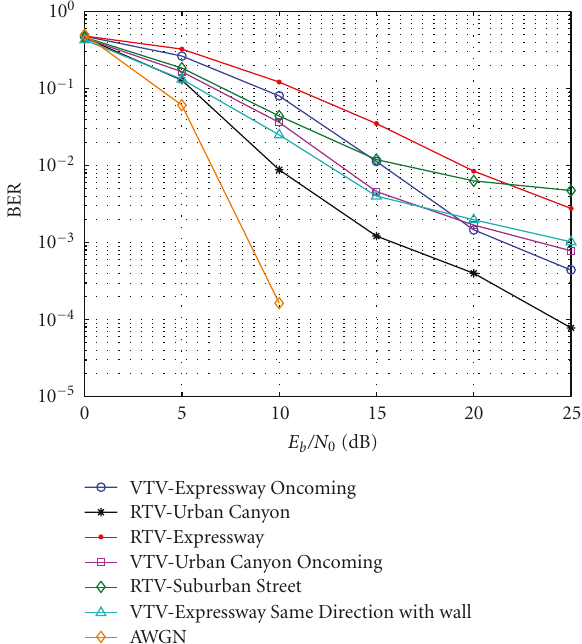
Figure 10: BER of the transceiver for the di ff erent vehicular